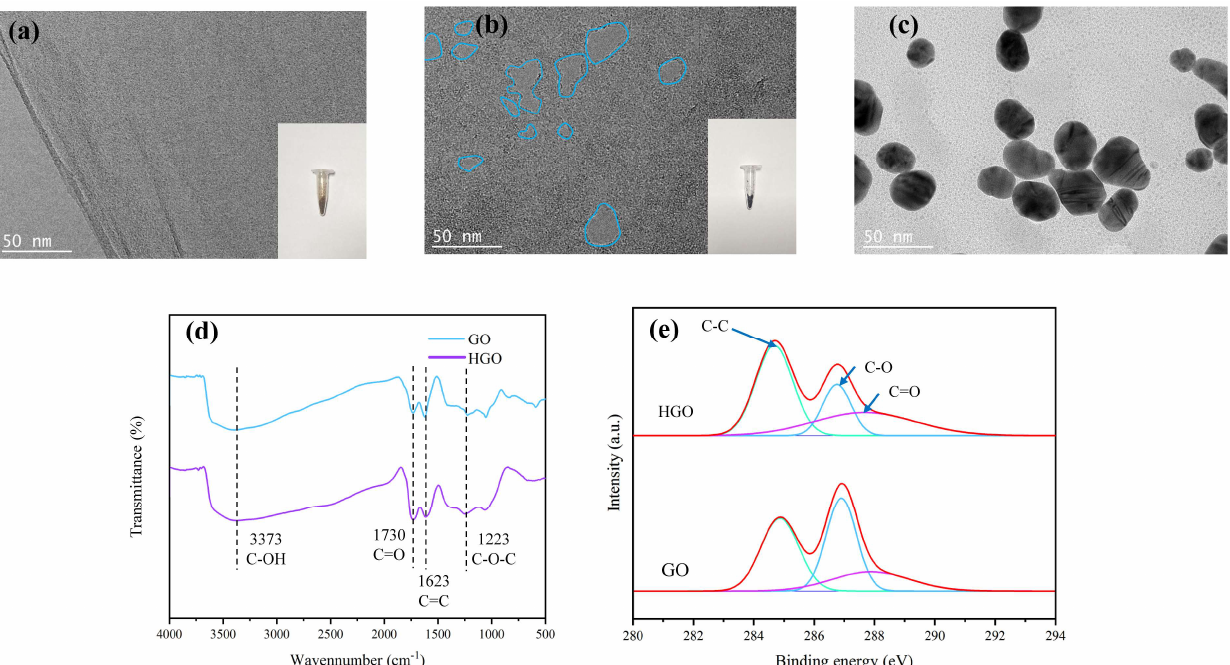
Figure 2. Characteristics analysis of GO/NGO. ( a ) TEM image (inserted panel shows synthesized powder) of GO, ( b ) TEM image (inserted panel shows synthesized powder) of NGO, ( c ) TEM image of Au NPs, ( d ) FT-IR spectra of GO and NGO, and ( e ) XPS spectra of GO and NGO.